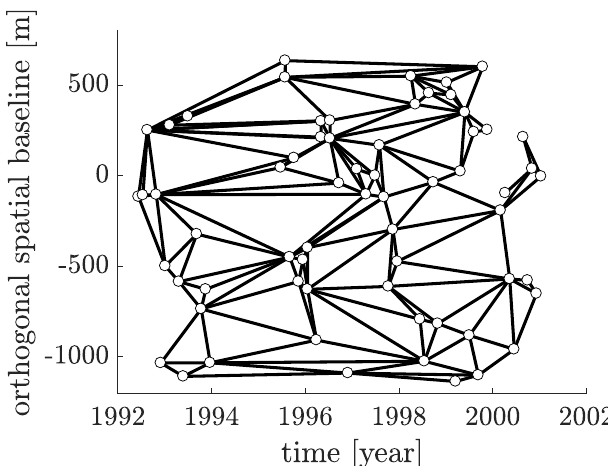
Figure 1. Temporal triangulation related to the Small BAseline Subset (SBAS) method with a set M (cid:48) of SAR images and a set N (cid:48) of interferograms. The white dots represent the individual SAR scenes at the individual acquisition times with corresponding orthogonal spatial baseline relating to the master scene. The black lines represent the interferograms. The spatial and temporal baseline information comes from the ERS 1/2 data from May 1992 to December